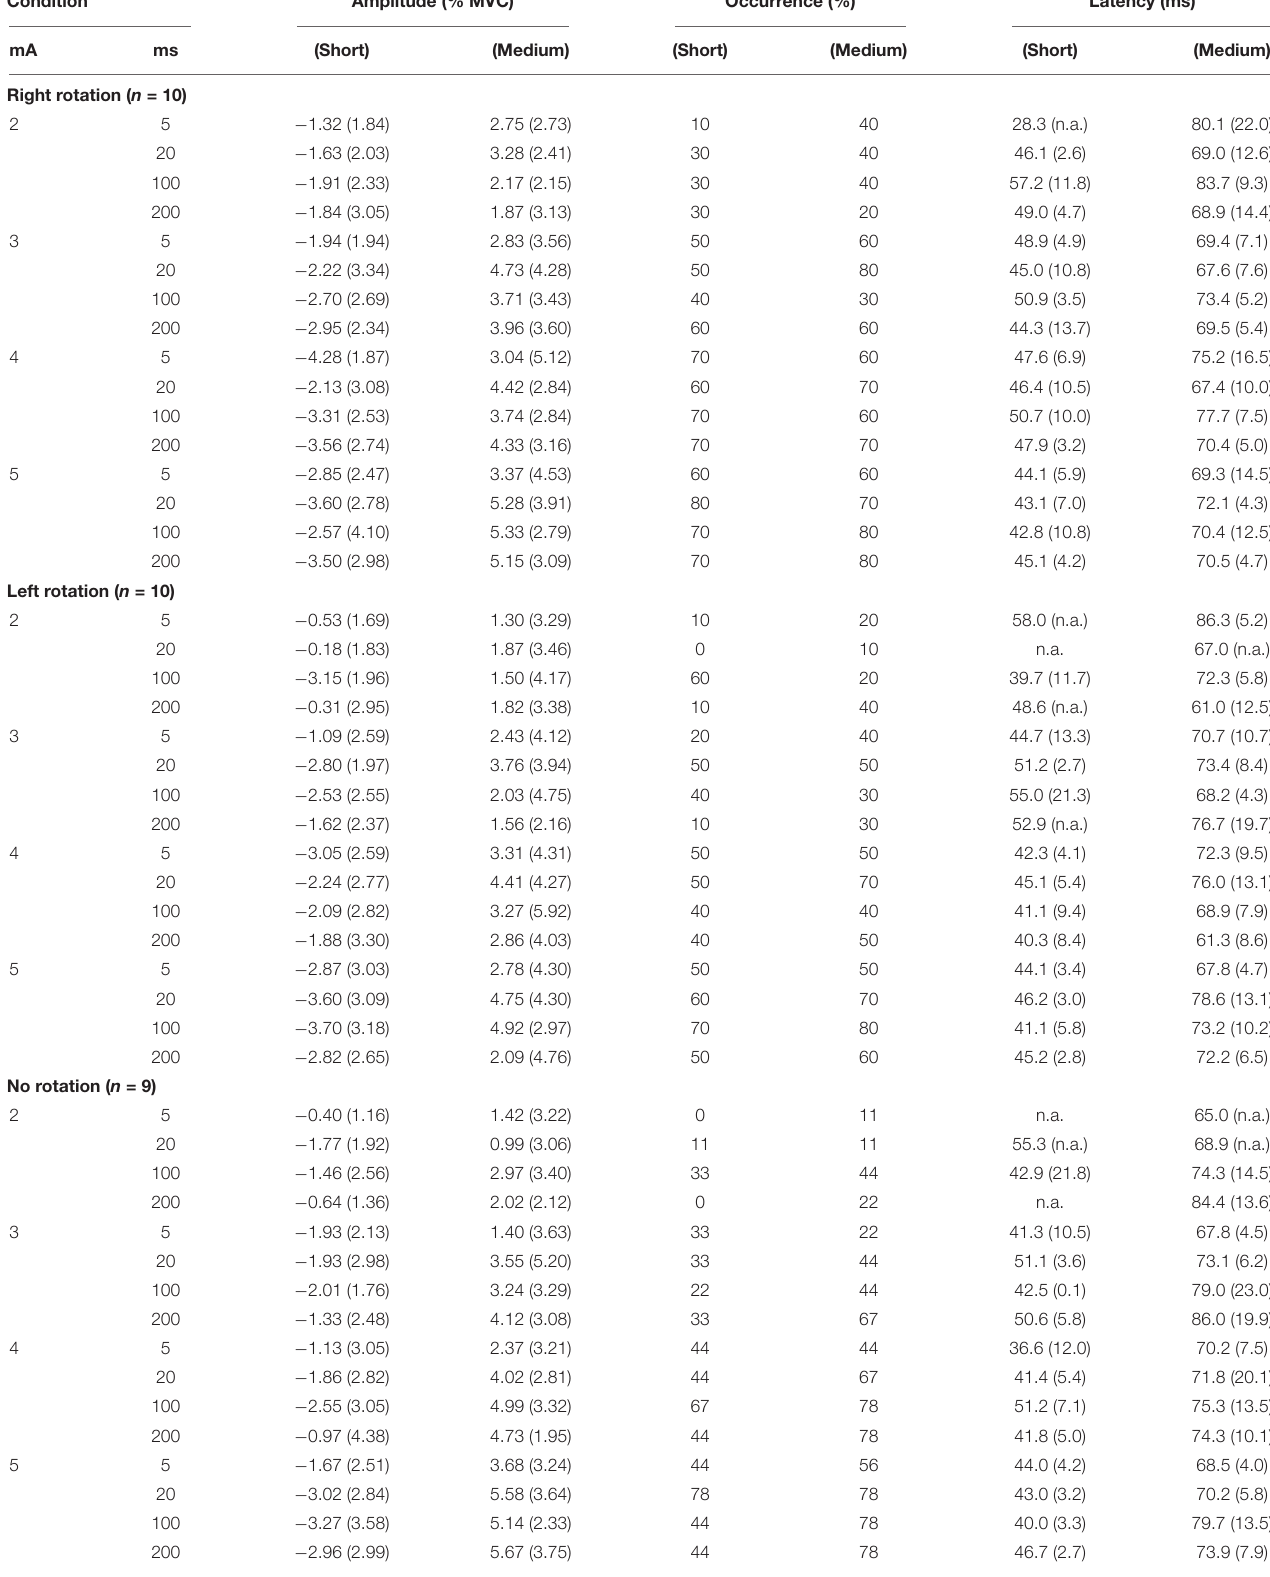
TABLE 1 | Mean amplitudes, occurrences and latencies of the short- and medium LES motor responses by condition [mean (SD)]. Condition Occurrence